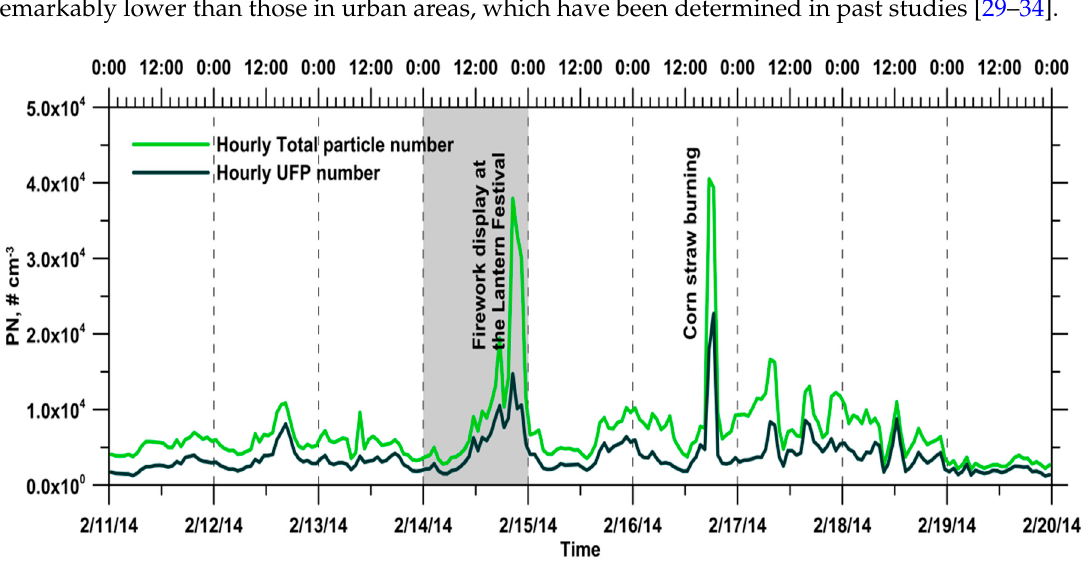
Figure 6. Time variations of the hourly total particle and UFP number concentrations at the monitoring site during the whole monitoring period. site during the whole monitoring